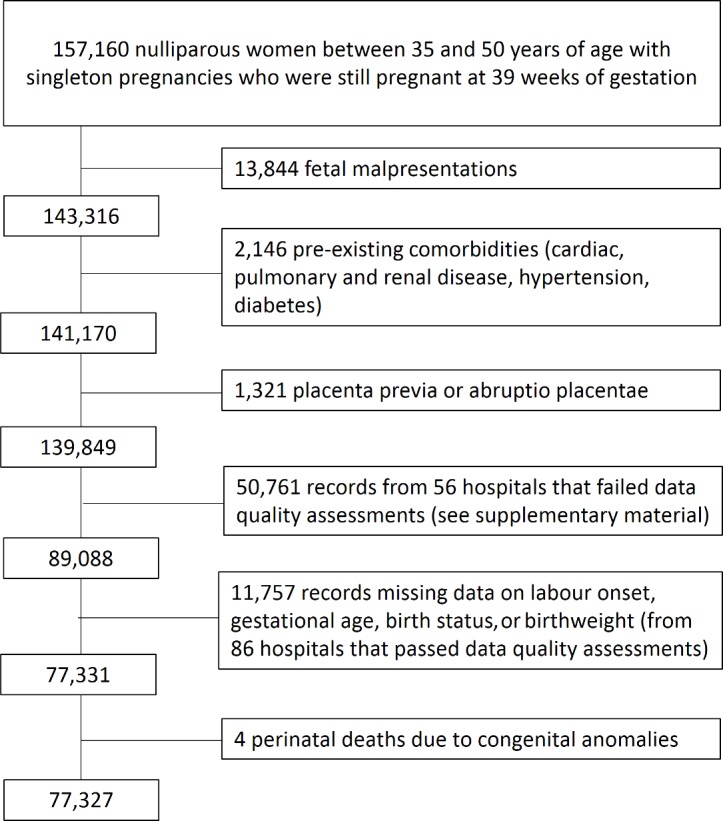
Cohort selection flow chart.